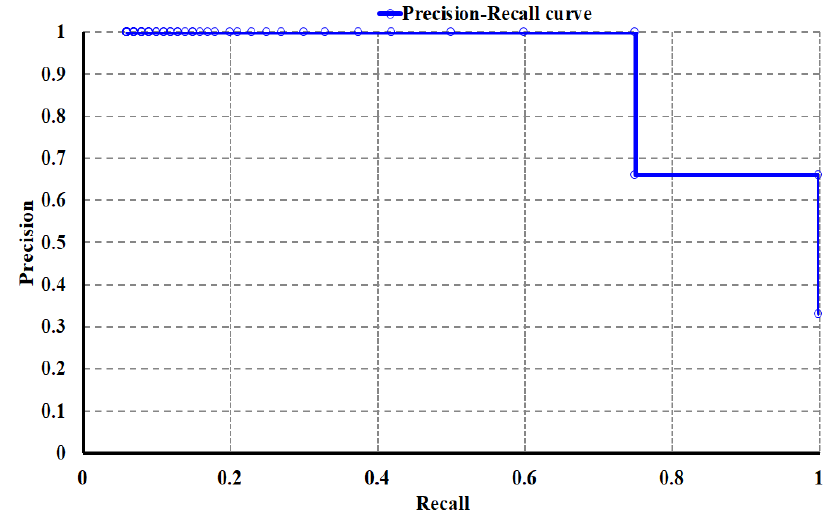
Figure 3. Precision–recall curve of our designed model.